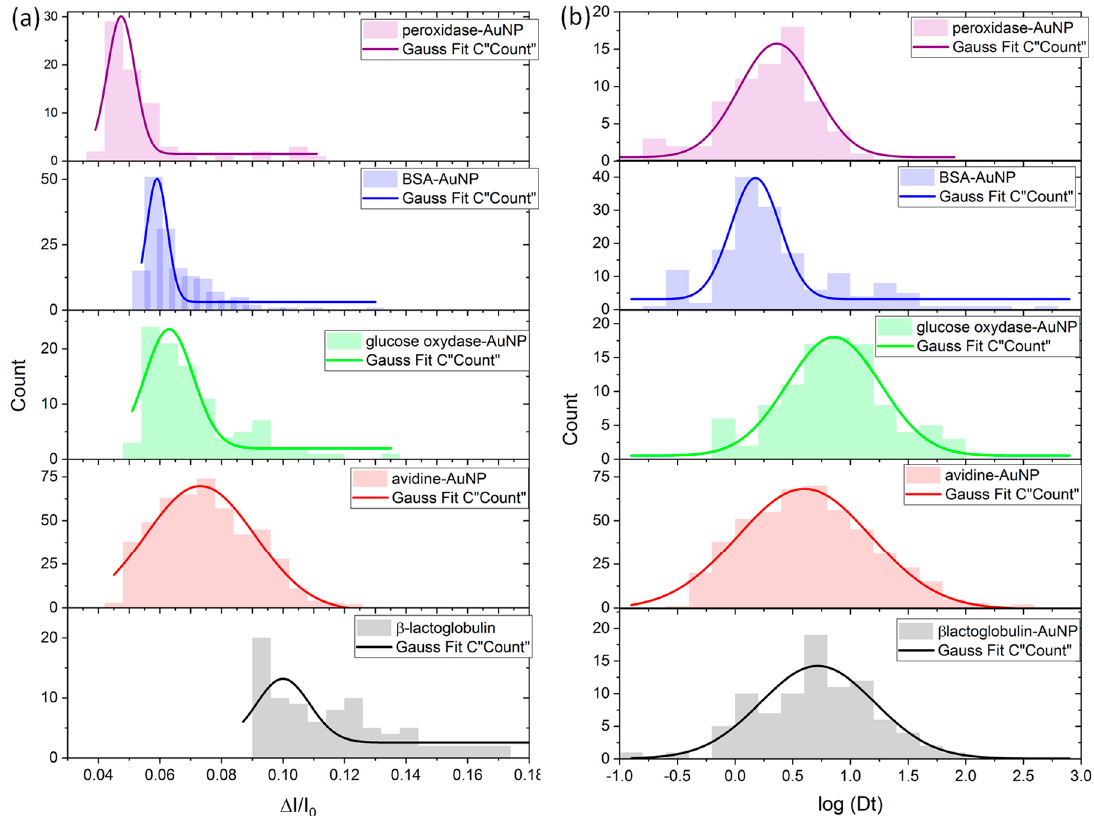
Figure 4. Distribution histograms of relative current blockade ( a ) and dwell time ( b ) obtained for peroxidase-AuNP (purple), BSA-AuNP (blue), glucose oxidase-AuNP (green), avidin-AuNP (red), β -lactoglobulin-AuNP (black).